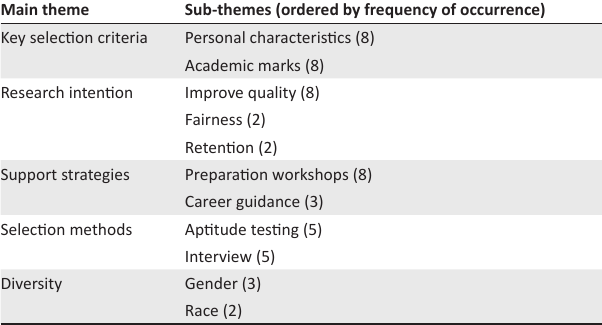
TABLE 6: Themes in apprentice selection